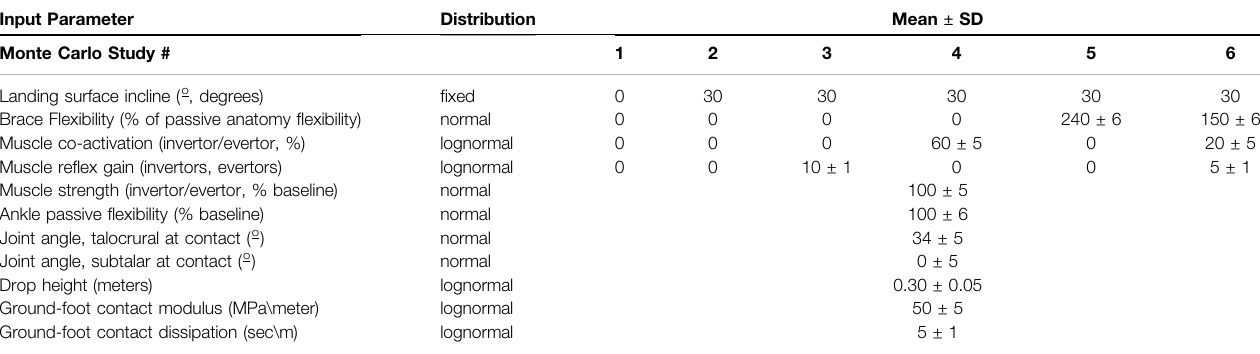
TABLE 1 | Probabilistic input parameters to six Monte Carlo simulations of single-limb drop landing. Each simulation was generated using 10 total parameters, where each had a fi xed landing surface incline, a common set of 7 probabilistic parameters, and either fi xed zero (0) or variable ranges of muscular co-activation, re fl ex gain, and brace fl